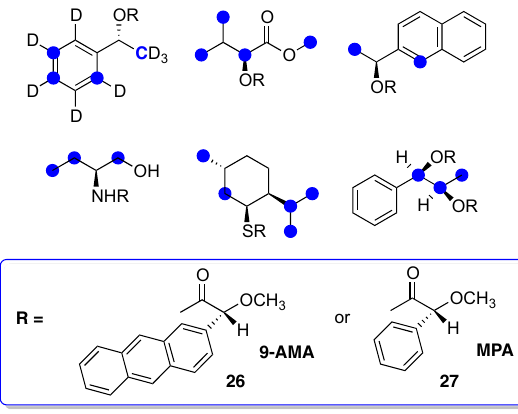
Scheme 21. Prediction of ∆ δ RS for 13 C nucleus of chiral organic